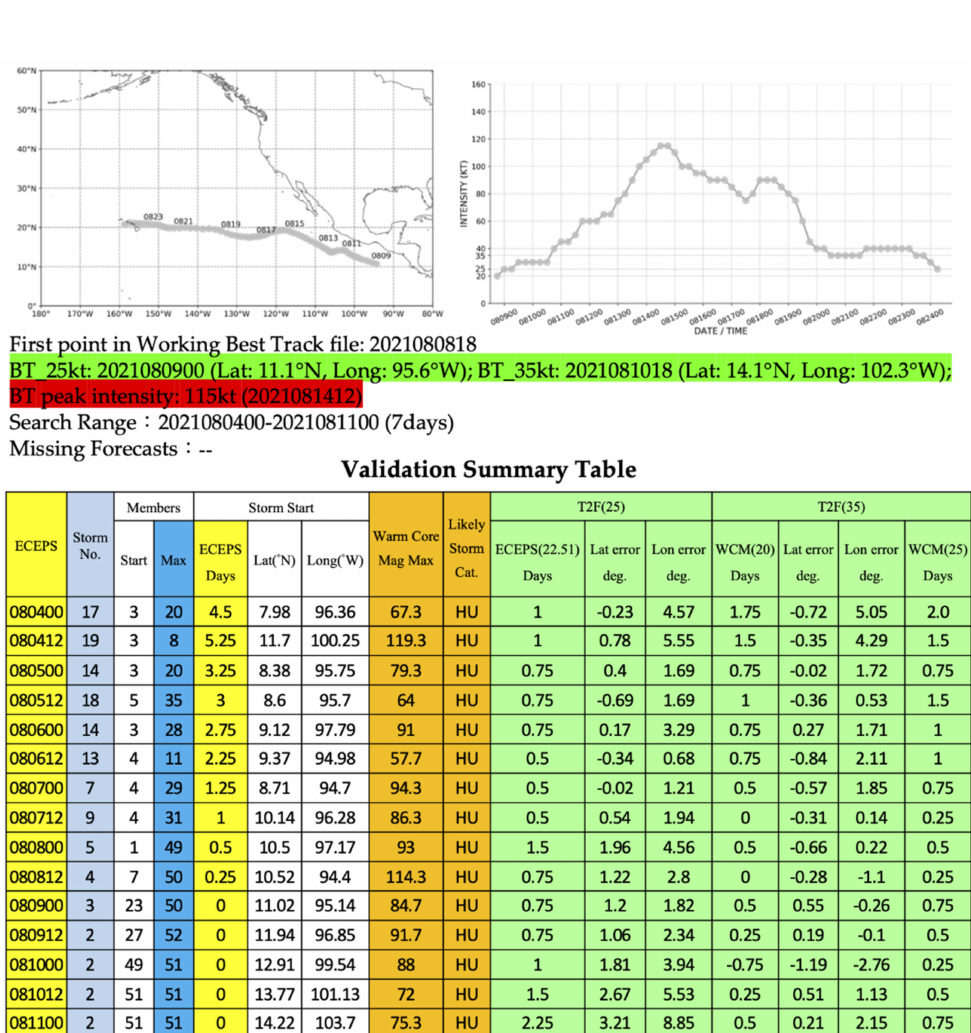
Figure 2. Hurricane Linda track and intensity plots with a validation summary table similar to Figure 1, except for the ECEPS pre-Linda forecasts and here in the original format of Elsberry et al. [1] to illustrate the information that is objectively derived from each forecast to assist the forecaster in evaluating and summarizing in time the